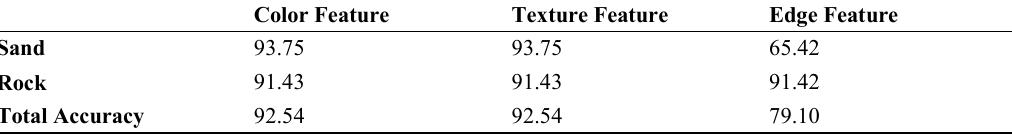
Table 2. Maximum test set accuracies obtained by the individual classifiers